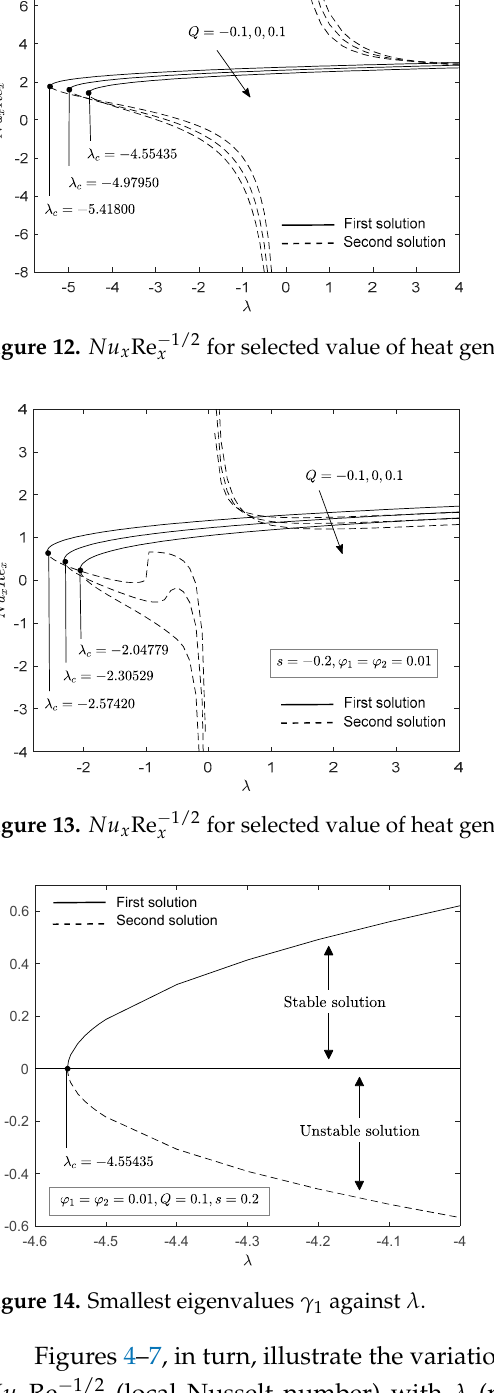
(skin friction coefficient) and